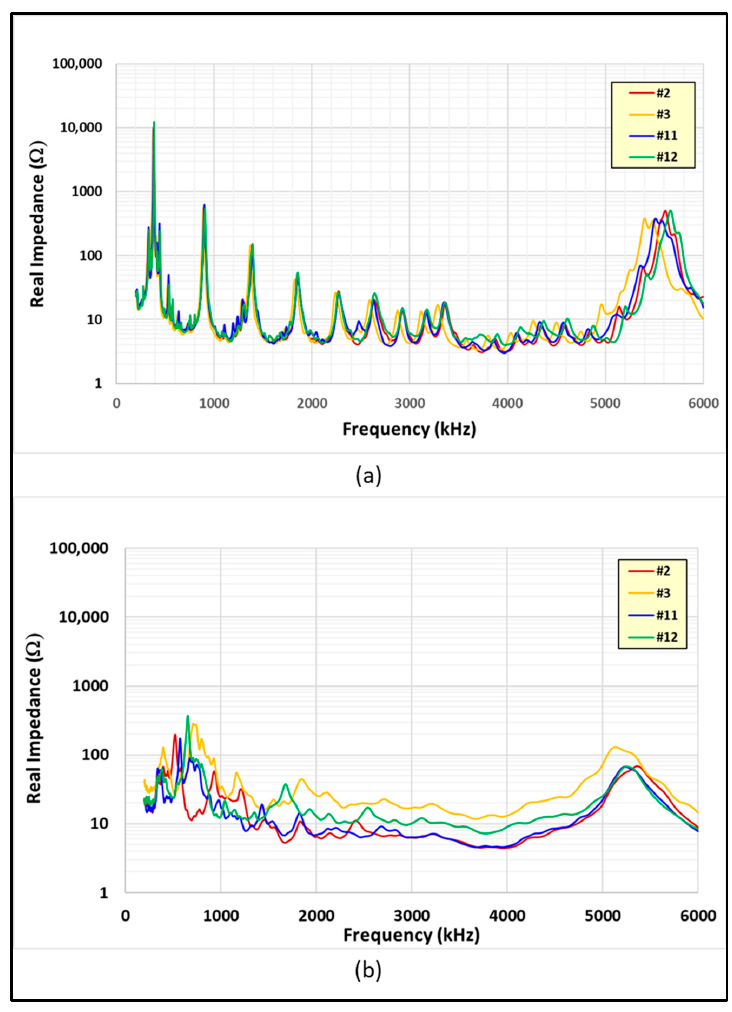
Figure 21. ( a ) Free sensor, ( b ) embedded sensor, baseline impedance results.